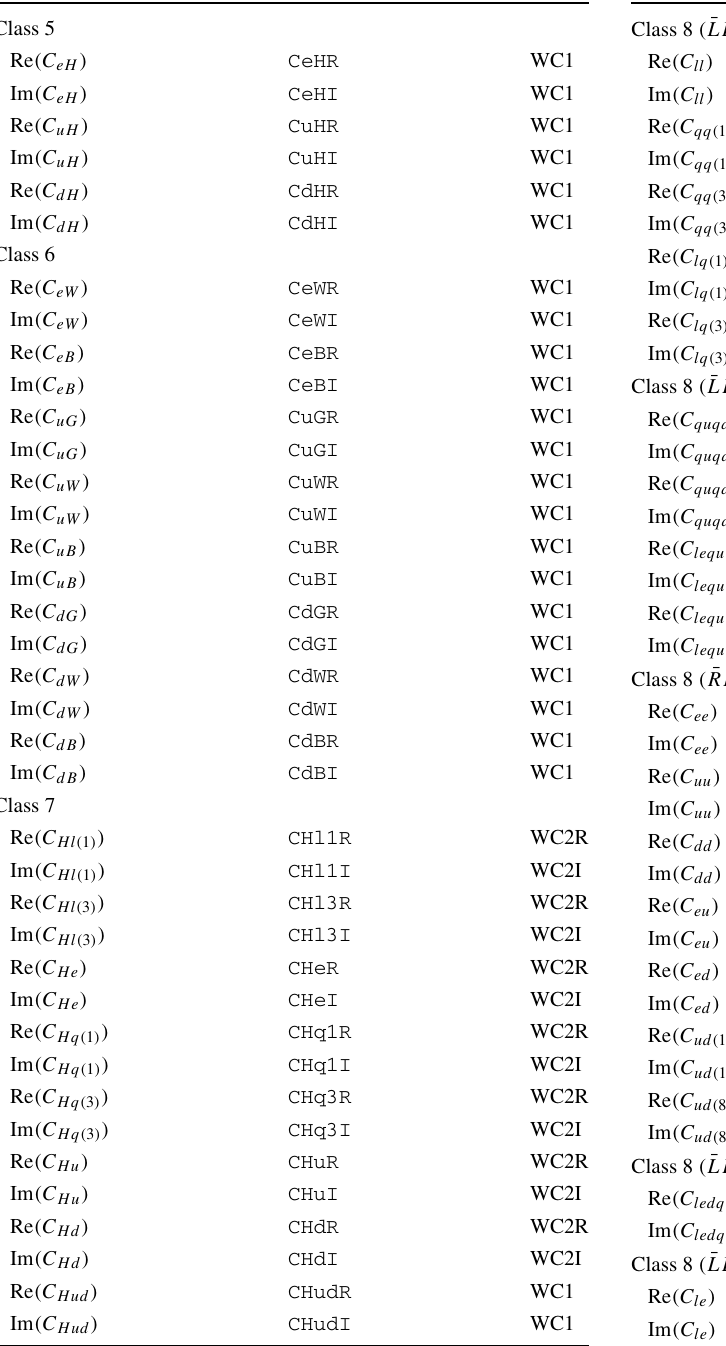
Table 7 SMEFT coefficients with two flavour indices in RGESolver Coeff.